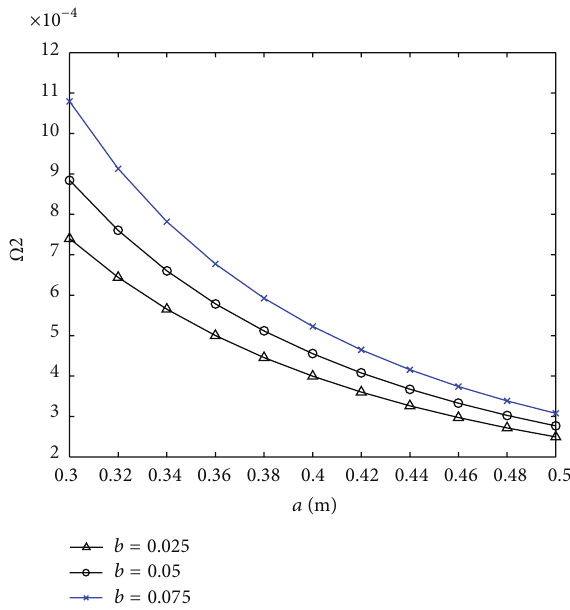
Figure 5: Variation of the second mode natural frequency with the radius of the plate for different hole radiuses and clamped-clamped boundary conditions ( ℎ 𝑐 = 1 mm).